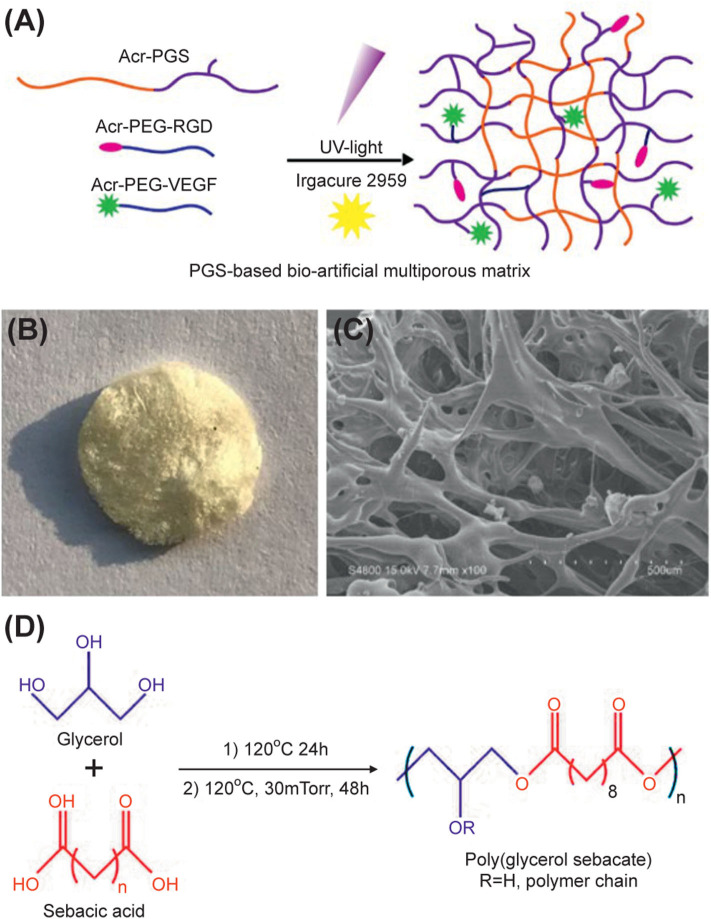
Design of PGS-based bio-artificial matrices. (A) Bioactive ligands RGD peptide, QK peptide are mono-PEG-acrylated for covalent crosslinking into PGS network. Addition of a photoinitiator to PGS aqueous solution of PGS followed by 10 min UV irradiation results in crosslinking of hydrogel through free radical polymerization of acrylate end groups before and after lyophilization. (B) Gross image of L-PGS-P. (C) SEM image of L-PGS-P. (D) Synthesis of poly (glycerol sebacate) polymer.